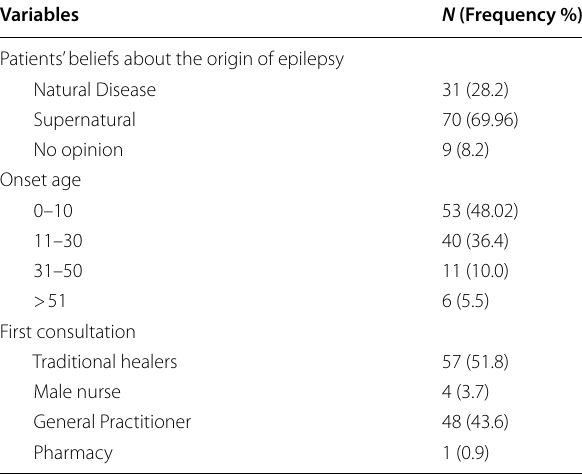
Table 2 Behaviour and therapeutic itinerary of patients